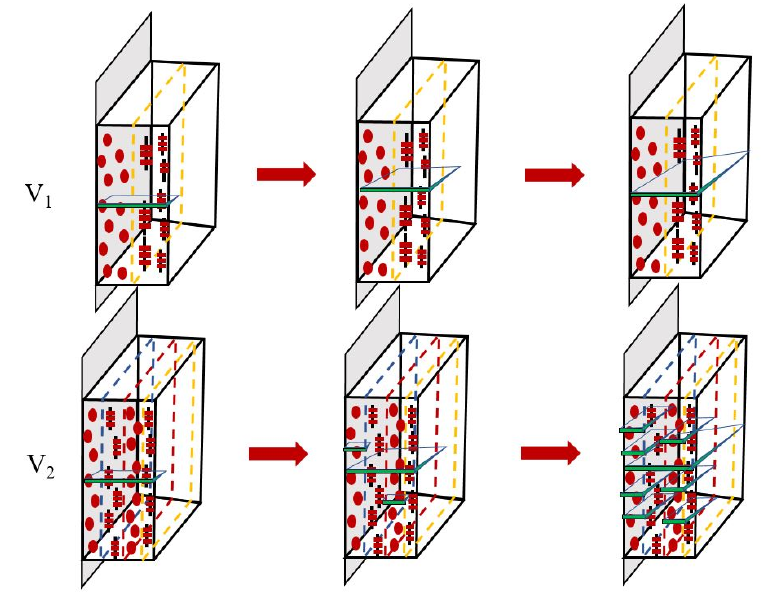
Figure 10. Schematic drawing of failure process of sample V 1 and V 2 under low initial load.